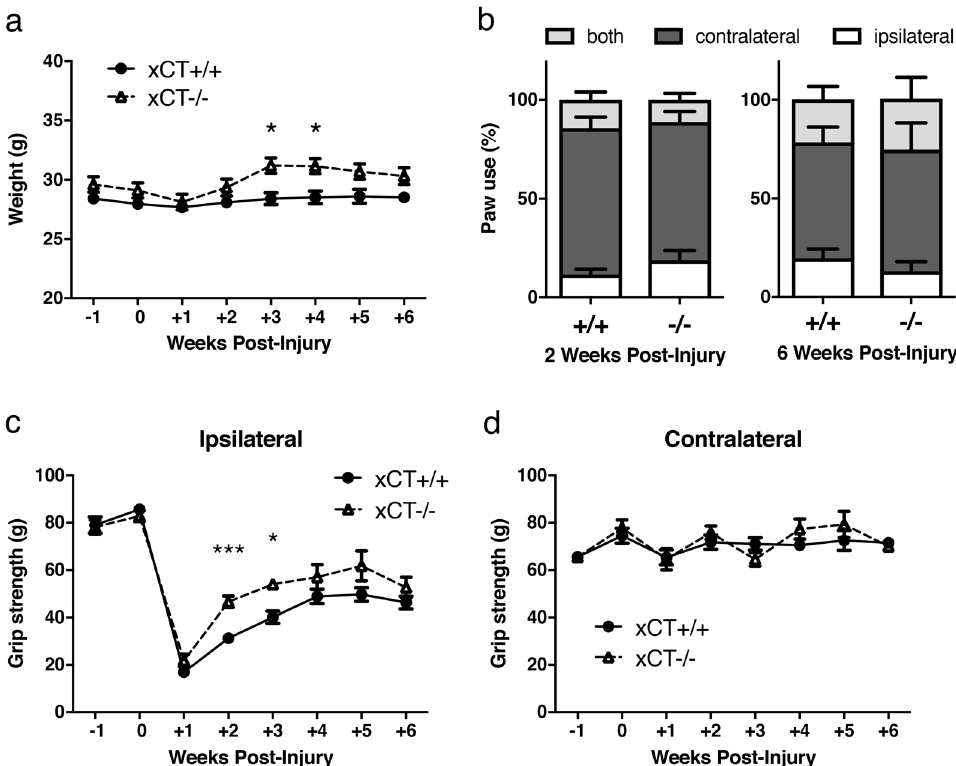
Figure 2. Evolution of weight and motor function in injured xCT+/+ and xCT−/− at different timing post- injury. xCT−/− mice recovered pre-SCI weight and gained weight faster than xCT+/+ between 3 and 4 weeks post-injury ( a ). Use of forelimbs, either ipsilateral or contralateral (or both) to the spinal lesion, was not different between injured xCT+/+ and xCT−/− mice ( b) . Grip strength test showed a better recovery of the ipsilateral grip strength for xCT−/− mice than for xCT+/+ mice at 2- and 3- weeks post-injury ( c ). Both groups of mice recovered similarly at later time points. The contralateral grip strength was not impaired by the unilateral spinal cord injury ( d ). * p < 0.05 and *** p < 0.001, two-way ANOVA followed by Sidak’s multiple comparisons, n = 10–12 mice/group between -1 and 2 weeks post-injury, n = 4–8 mice/group between 3 and 6 weeks post-injury. Data are expressed as mean +/−